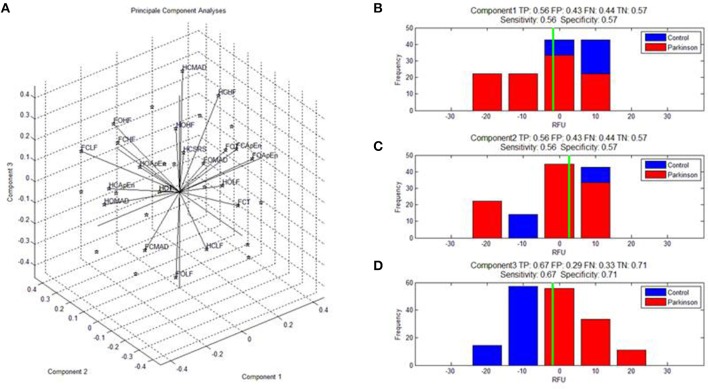
(A) Shows the features calculated on the dynamic of the center of pressure monitored during the four paradigms and expressed in the space defined by the first three components of the PCA. Abbreviations for the binomes (feature,paradigm) are detailed in Table 1. SRS indicate the scoring to the DHI. (B–D) Shows the specificity and selectivity of component 1, 2, and to discriminate parkinsonian patients from healthy subjects. TP, true positive; TN, true negative; FP, false positive; and TN, true negative.